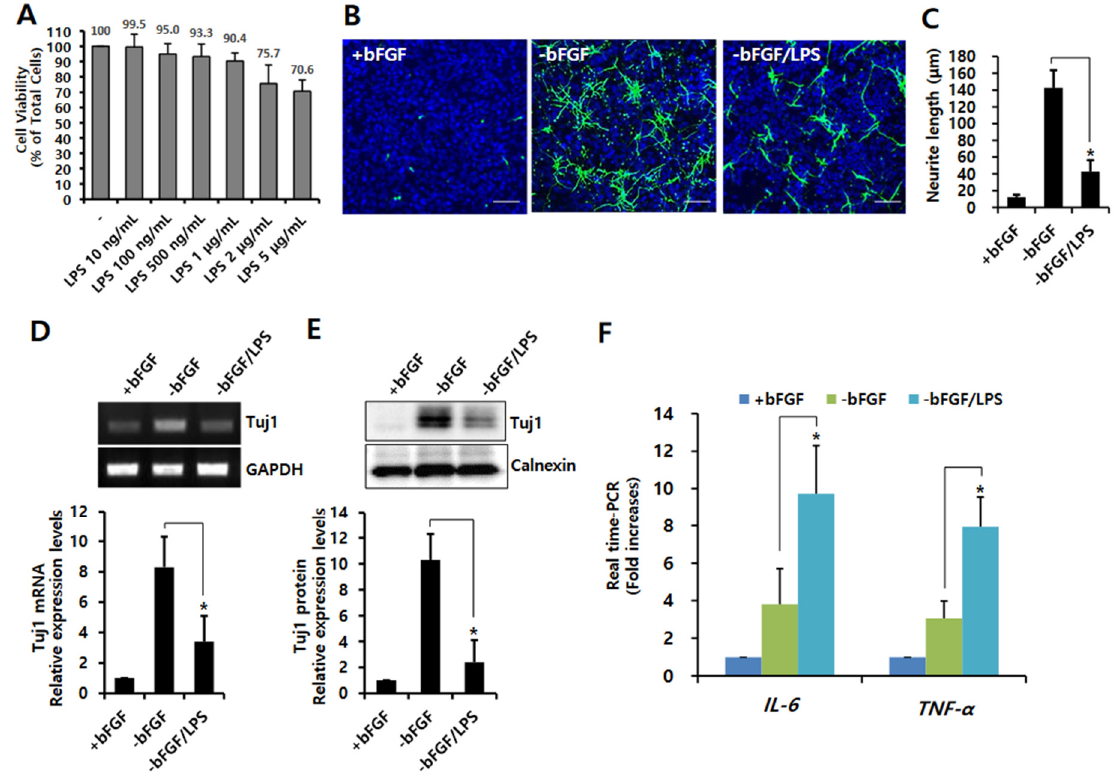
Figure 1. Effect of LPS stimulation on neuronal differentiation in NSCs. During the growth of isolated NSCs, bFGF was present (+bFGF, proliferation condition) to prevent differentiation and promote proliferation. In order to induce the neuronal differentiation, bFGF was removed (-bFGF, differentiation condition). ( A ) Cell viability in LPS-treated NSCs. NSCs were treated with LPS at 10 ng, 100 ng, 500 ng, 1 µ g, 2 µ g, or 5 µ g/mL for 1 day in the absence of bFGF. The cells were collected for analysis for cell viability and performed using the Cell counting Kit-8. Absorbance was measured at 450 nm, and all experiments were performed in triplicate. Cytotoxic activity is expressed as the percentage of cell viability using the formula: cytotoxicity (%) = (1 − A450 of target cells/A450 of control cells) × 100; n = 3. Data are shown as means ± SD. ( B , C ) NSCs were treated with LPS (1 µ g/mL) for 3 days in the absence of bFGF. They were stained with anti-Tuj1 (green) and DAPI (blue). Scale bar: 100 µ m. ( C ) Neurite lengths were measured in randomly selected fields using three independent experiments, with n = 3 per group. Data are shown as means ± SD. * p < 0.05 compared with –bFGF control. ( D ) The cells were treated with LPS (1 µ g/mL) for 12 h in the absence of bFGF. The Tuj1 mRNA level was analyzed using RT-PCR (upper panel) and real time-RT-PCR (graph); n = 3. Data are shown as means ± SD. * p < 0.05 compared with–bFGF control. ( E ) The cells were treated with LPS (1 µ g/mL) for 1 day in the absence of bFGF. Western blotting was performed using anti-Tuj1 or anti-calnexin antibodies to detect the respective protein bands (upper panel). Band intensity (graph) was quantified with Quantity Ones ® software. Data are shown as means ± SD. * p < 0.05 compared with –bFGF control. ( F ) The cells were treated with LPS (1 µ g/mL) for 12 h in the absence of bFGF. The mRNA levels of IL-6 and TNF- α were analyzed by real-time RT-PCR; n = 3. Data are shown as means ± SD. * p < 0.05 compared with –bFGF control, for IL-6 and TNF- α , respectively. Statistical significances were assessed by one-way ANOVA with a post hoc Tukey’s